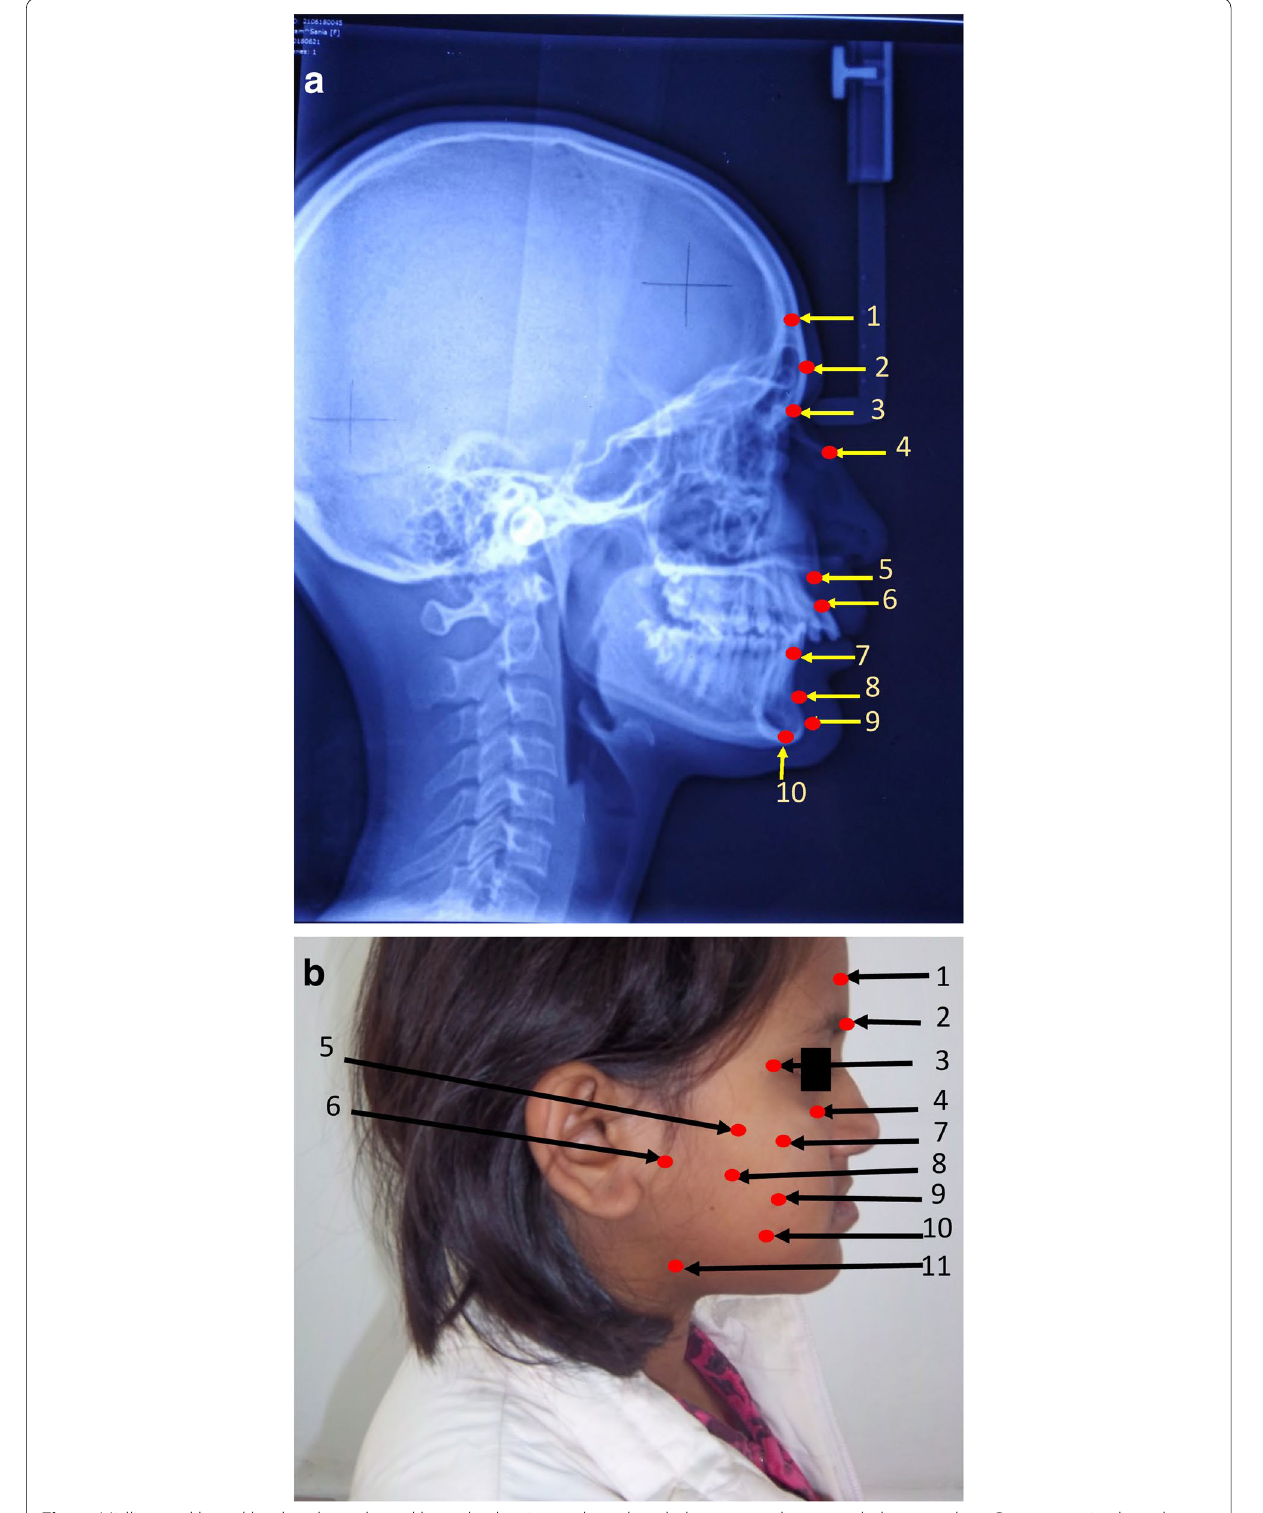
Fig. 4 Midline and lateral landmarks evaluated by orthodontists on lateral cephalograms and extra-oral photographs. a Representative lateral cephalogram showing midline landmarks for FSTT (Landmarks specified in Table 4). b Extrapolation of lateral skull landmarks on representative extra-oral photograph of patient (consent obtained for photograph) (landmarks specified in Table